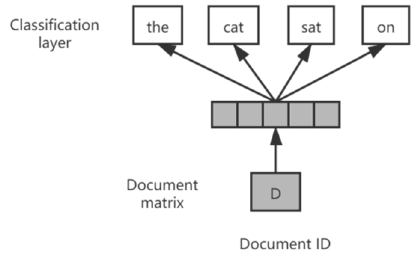
Figure 3. Structure of the PV-DBOW training sentence vector.